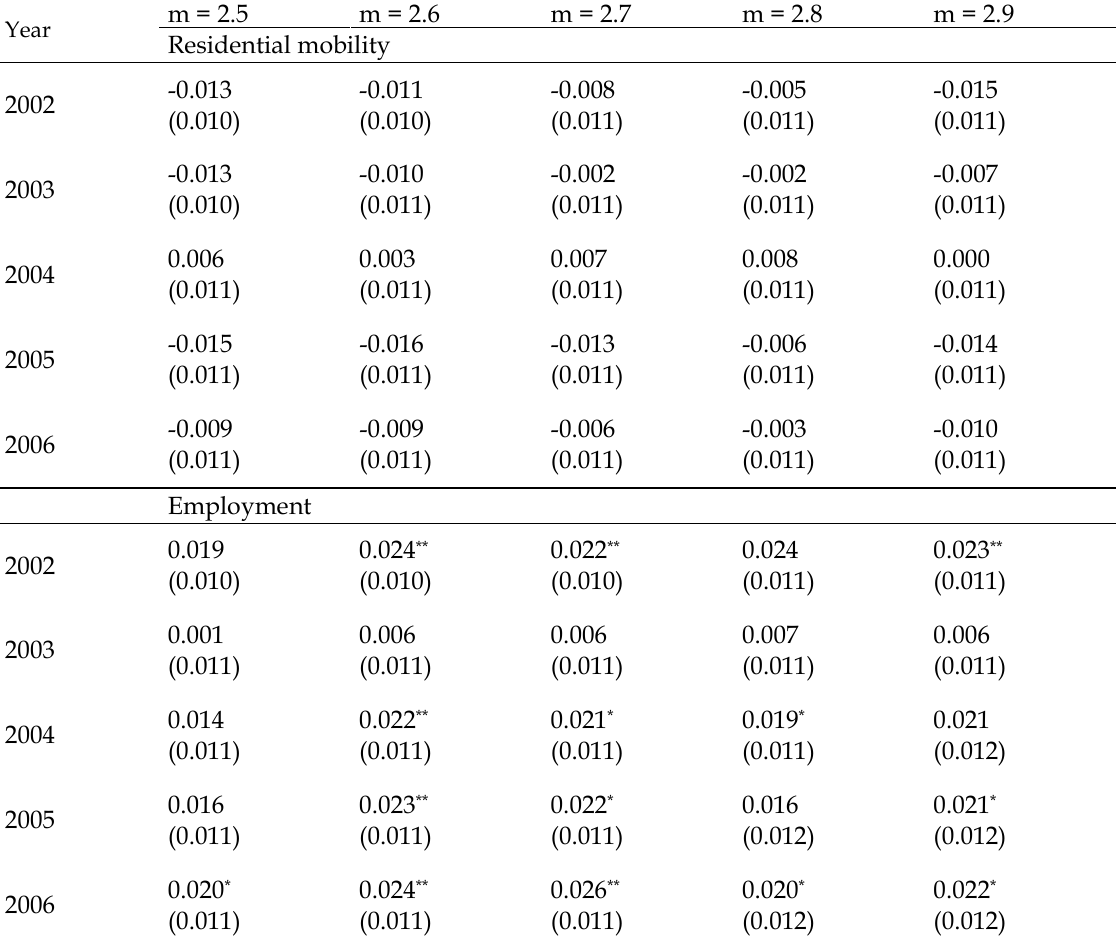
Table A1. Estimated post-treatment effect of improved job accessibility on residential mobility and employment